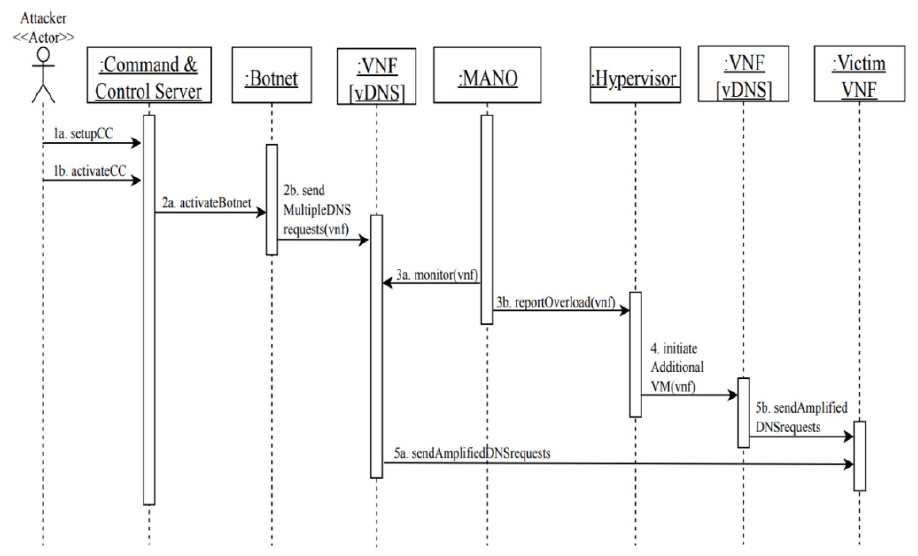
Figure 9. Sequence diagram for MC3: distributed denial-of-service attack in NFV using DNS amplification attack .